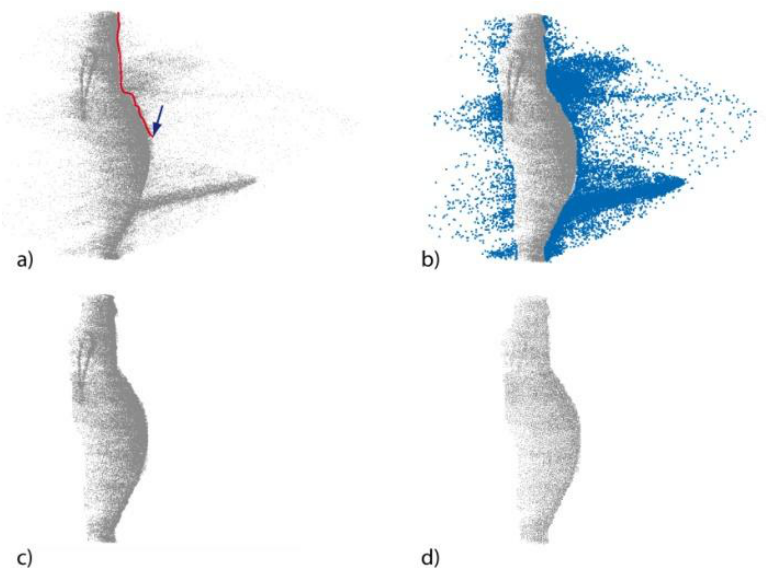
Figure 9. Point cloud cleaning procedure. Outlier point manual selection ( a ), selected outlier points ( b ), cleaned point cloud after outlier deletion ( c ) and final point cloud after noise filtering application ( d ).